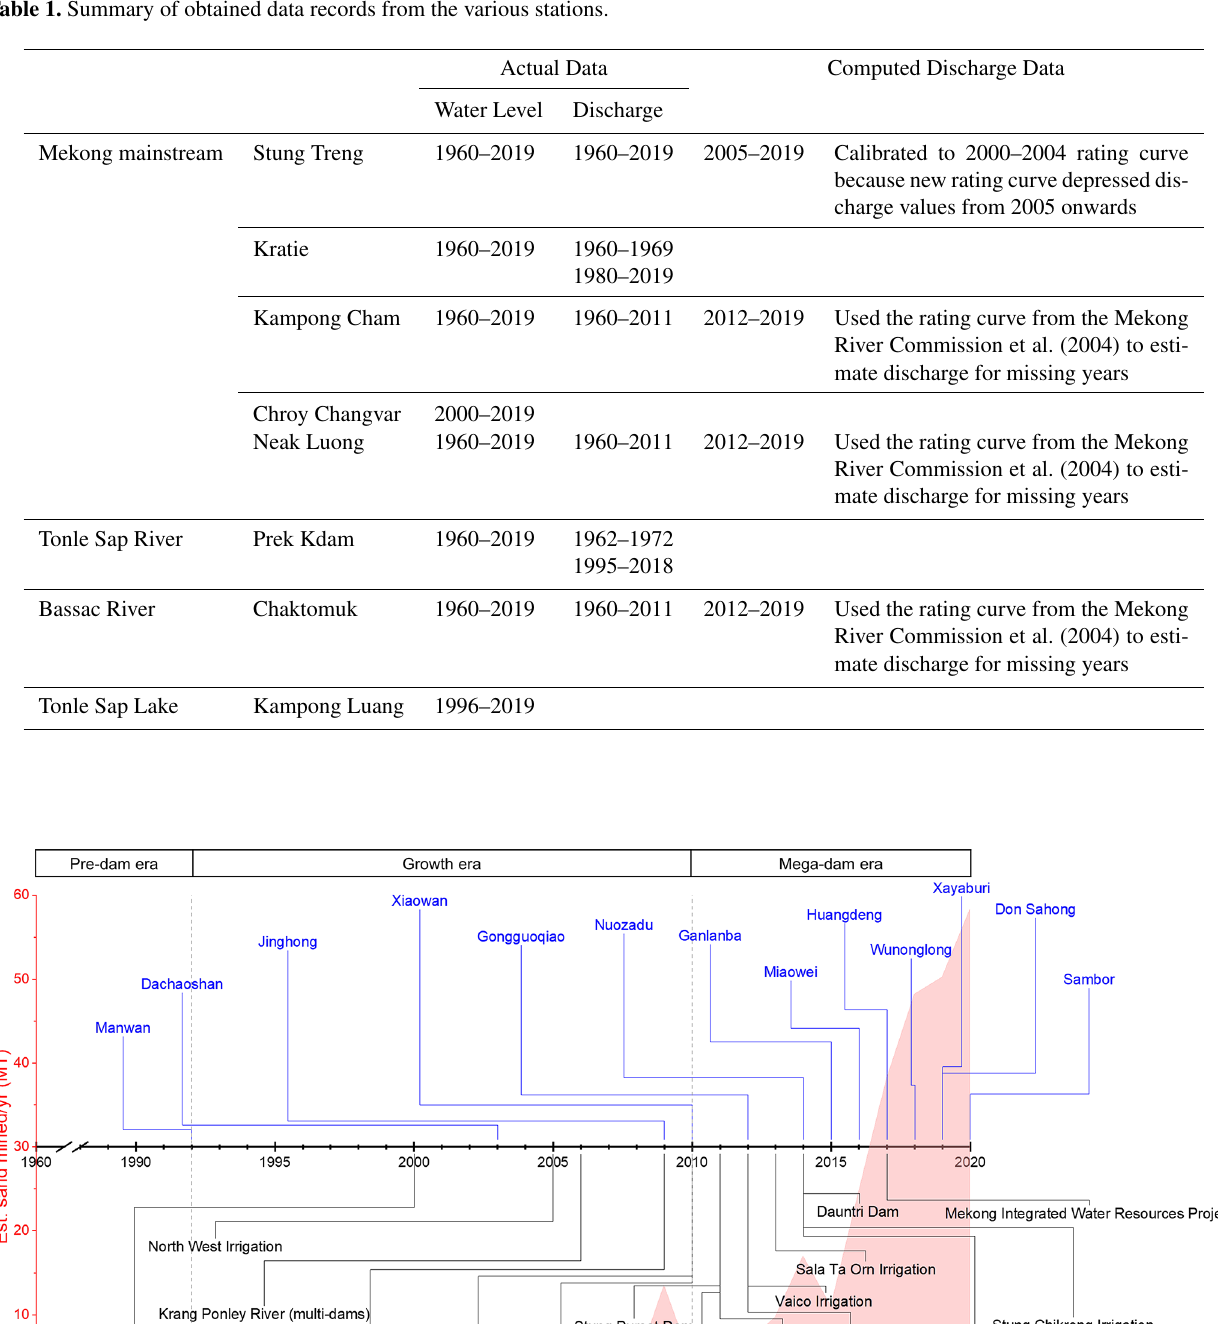
Table 1. Summary of obtained data records from the various stations.